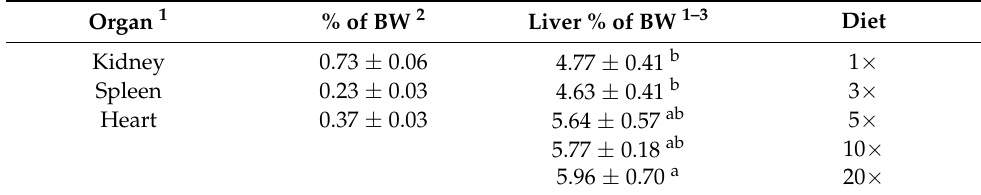
Table 5. Dam’s organ weights in experiment